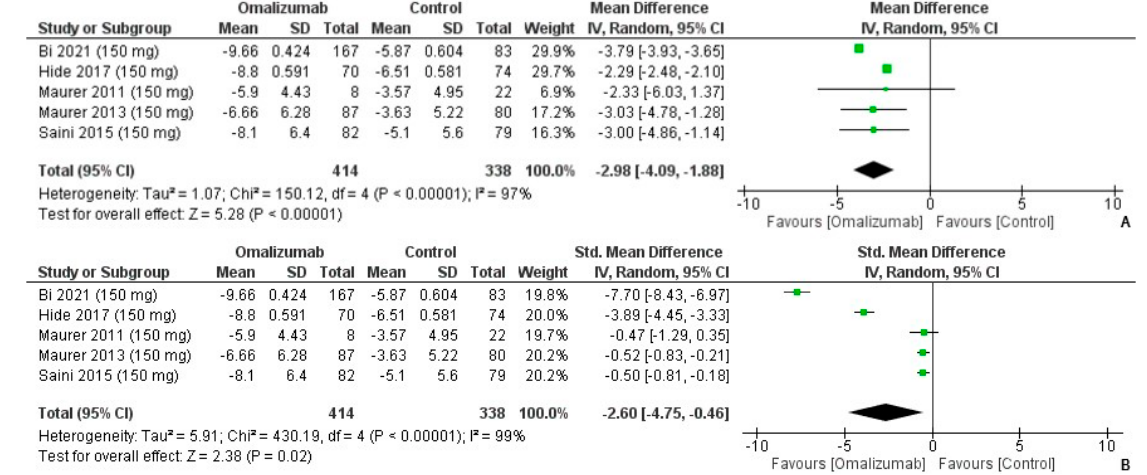
Figure 4. Weekly Itch Score Outcomes with 300 mg dosage of omalizumab [17 − 26]. ( A ): Mean dif- ference: − 4.09 [95% CI: − 4.76, − 3.42]; Heterogeneity: Tau² = 0.47; Chi² = 79.48, df = 9 ( p < 0.00001); I² = Figure 3. Weekly Itch Score Outcomes with 150 mg dosage of omalizumab [17 − 19,25,26]. ( A ): Mean 89%; Test for overall effect: Z = 11.95 ( p < 0.00001). ( B ): Standardized mean difference: − 2.21 [95% CI: difference: − 2.98 [95% CI: − 4.09, − 1.88]; Heterogeneity: Tau² = 1.07; Chi² = 150.12, df = 4 ( p < 0.00001); − 3.35, − 1.06]; Heterogeneity: Tau² = 3.31; Chi² = 527.08, df = 9 ( p < 0.00001); I² = 98%; Test for overall I² = 97%; Test for overall effect: Z = 5.28 ( p < 0.00001). ( B ): Standardized mean difference: − 2.60 [95%